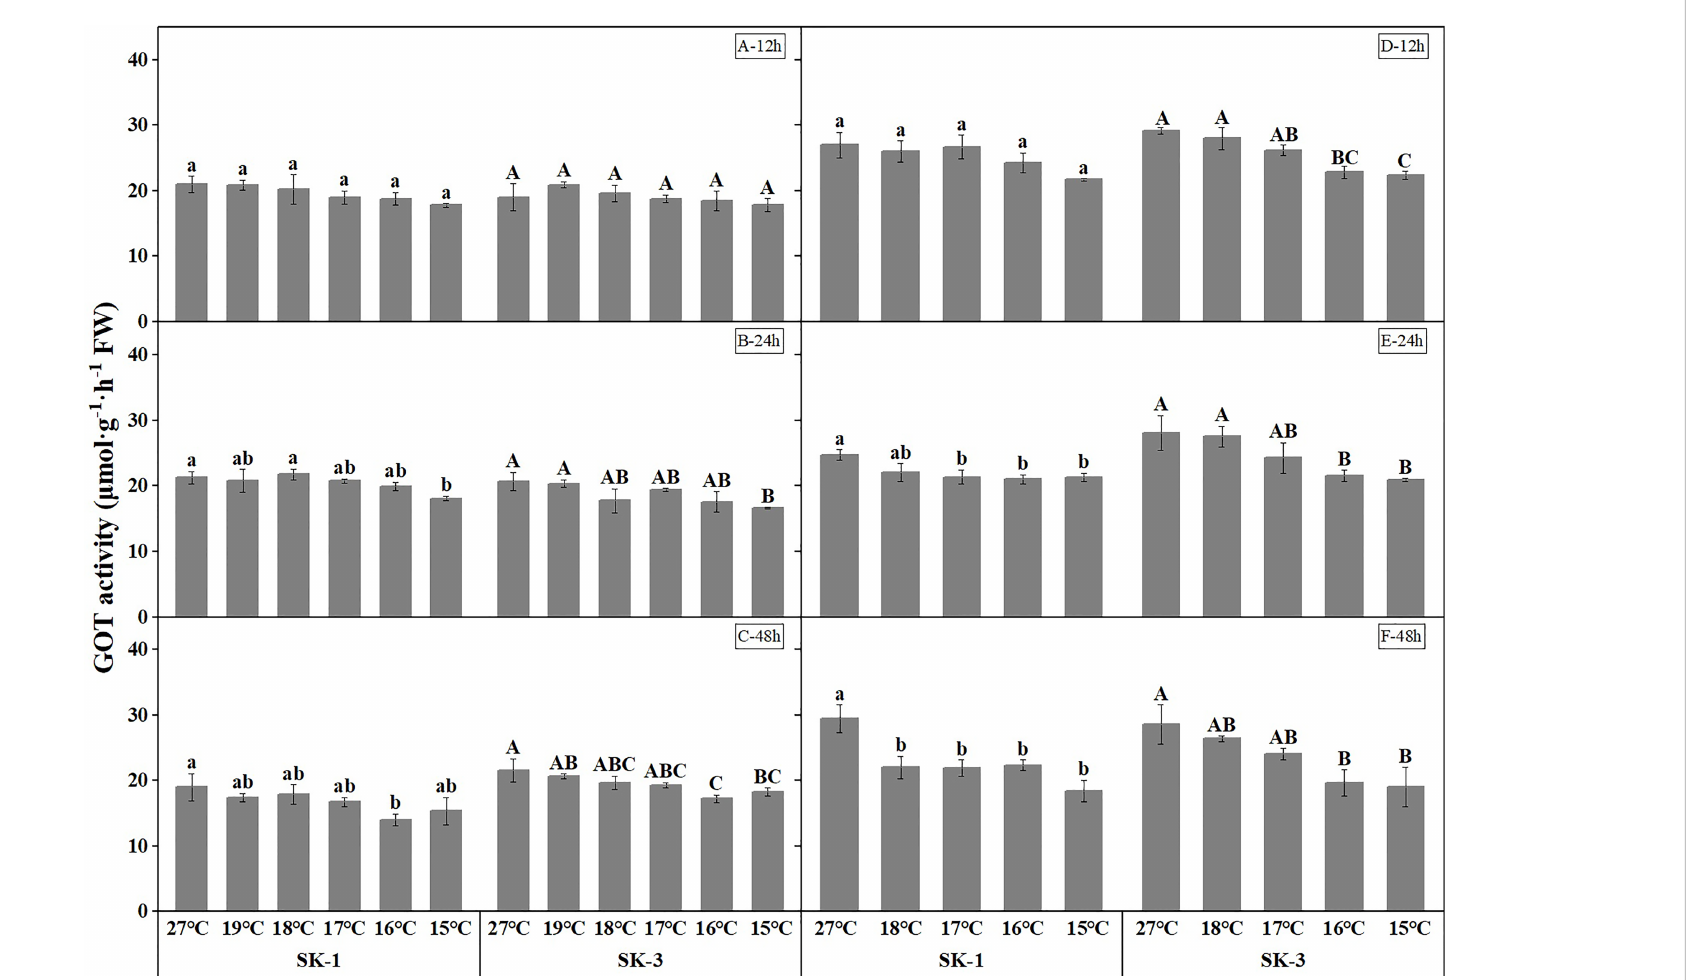
FIGURE 9 Effect of low temperature stress on GOT activity in cotton squares in 2020 ( A-C : 12h, 24h, 48h stress) and 2021 ( D-F : 12h, 24h, 48h stress). FW represents fresh weight. Different lowercase letters indicate the signi fi cant differences between the treatments of the variety SK1, and different capital letters indicate the signi fi cant differences between the treatments of the variety SK3